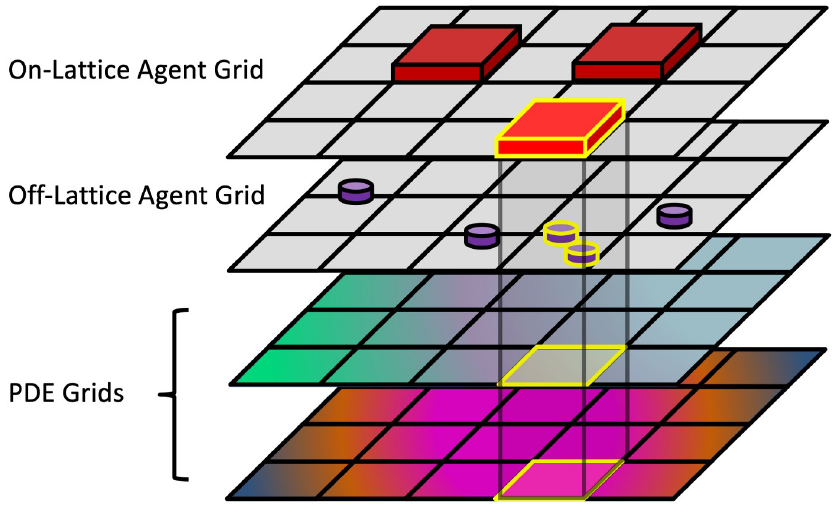
Fig 1. HAL’s decentralized design helps build complex models out of simple components. The highlighted on- lattice agent in the topmost grid searches for local overlaps with several other grids and PDEs. These overlaps can be used in a model to generate spatial